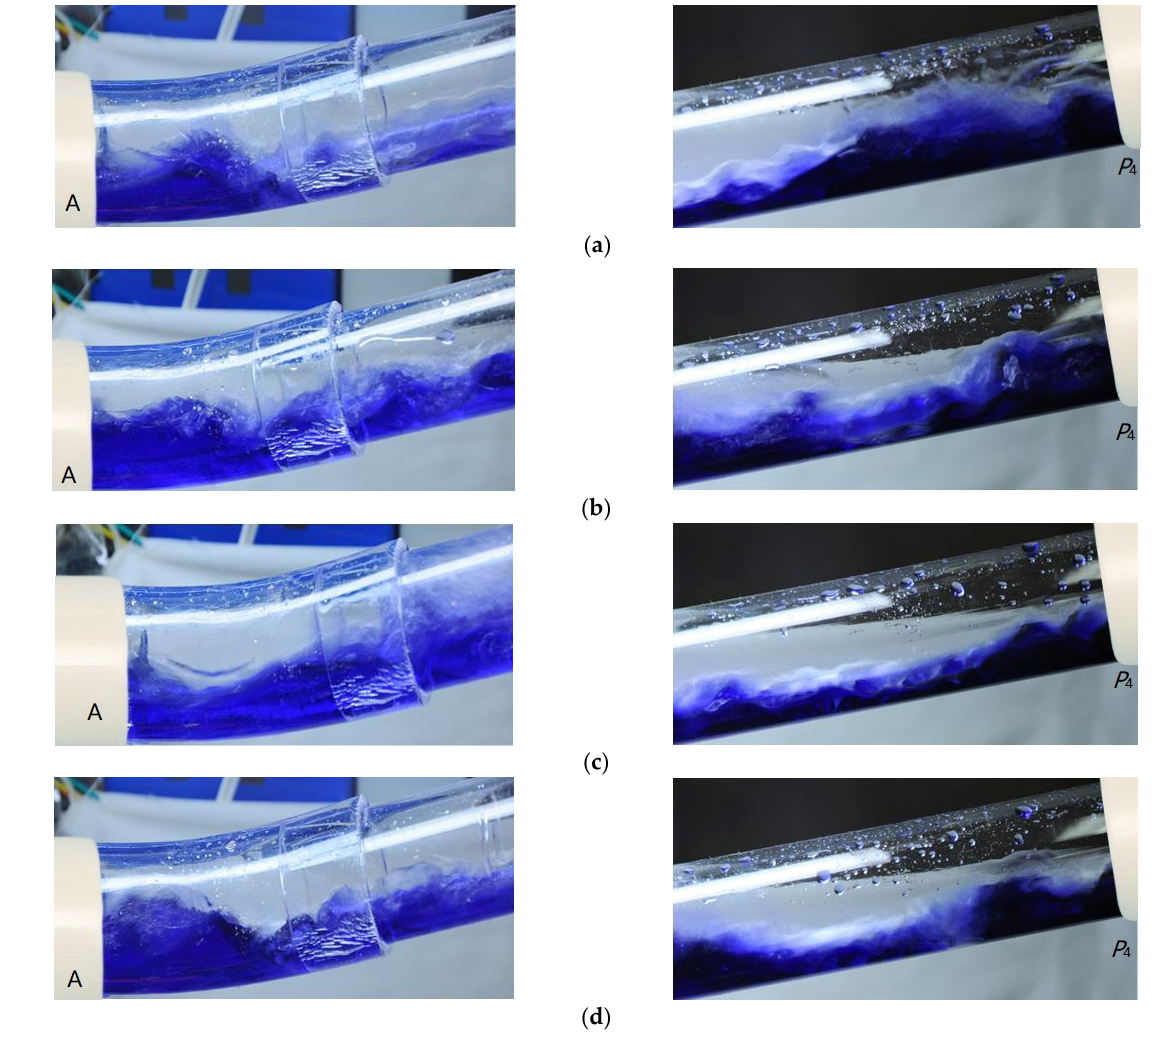
Figure 12. Slug flow pipeline pressure distribution 15°: ( a ) flow image in the pipeline at point A and P 4 at time t 1 ; ( b ) flow image in the pipeline at point A and P 4 at time t 2 ; ( c ) flow image in the pipeline at point A and P 4 at time t 3 ; ( d ) flow image in the pipeline at point A and P 4 at time t 4 .